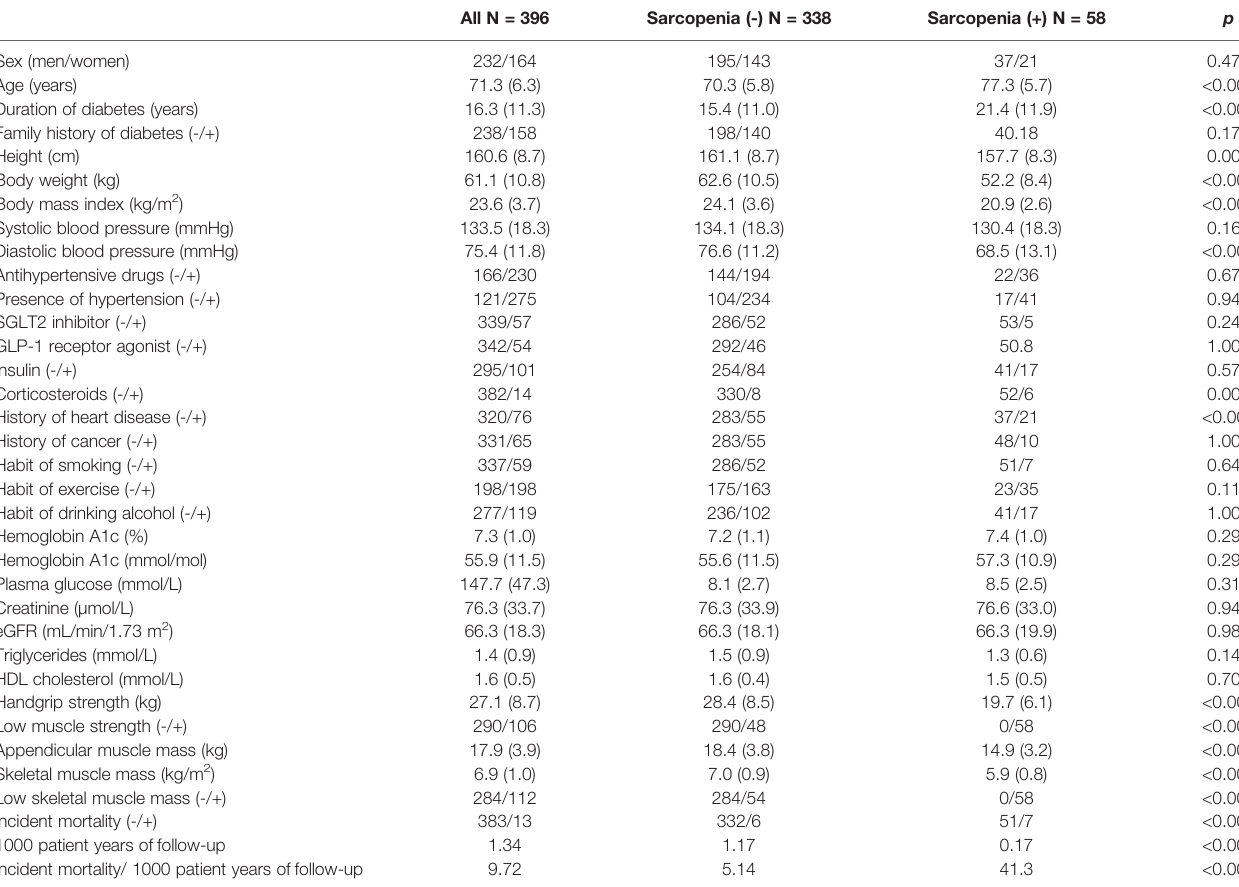
TABLE 1 | Clinical characteristics of study participants with and without sarcopenia.